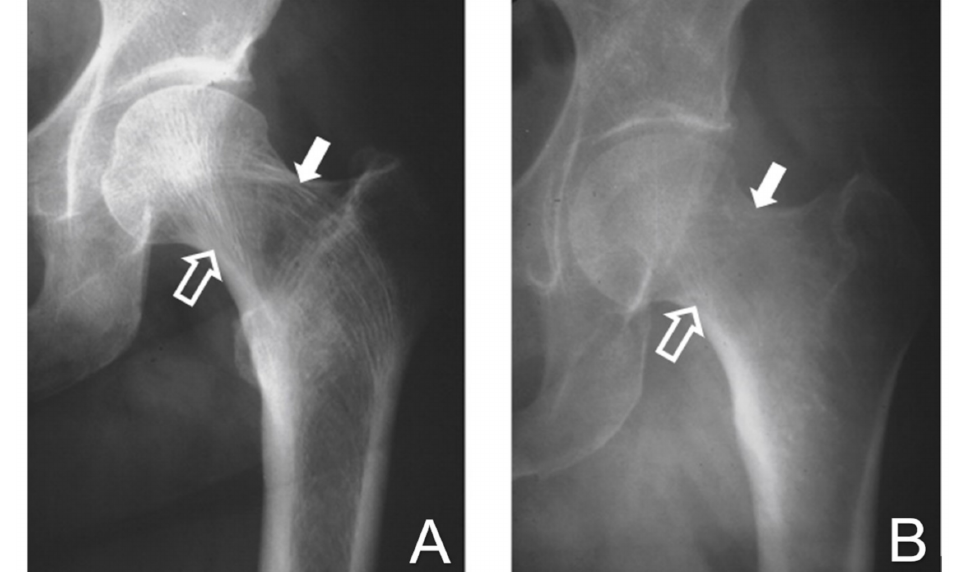
Figure 2. Anteroposterior radiographs of the human proximal femur showing the response to physiological loading ( A ) and osteoporosis ( B ). ( A ) In the normal femoral head, trabeculae align along lines of weight-bearing stress and tissue strain patterns. Compressive trabeculae (open arrows) transmit strain from the joint reactive forces to the medial femoral cortex. Tensile trabeculae (solid arrows) align to resist bending moments due to the offset of the center of rotation of the femoral head from the femoral shaft and transmit bending stress to the lateral femoral cortex. ( B ) In the osteoporotic femoral head, osteoblasts are not responsive to mechanical strain patterns and the trabecular orientation is diminished or lost. Adapted with permission from Ref. [3]. 2022, Rhode Island Medical Journal